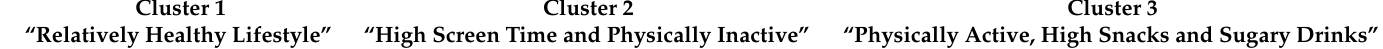
Table 2. Child lifestyle behaviours by cluster distribution ( n = 4059).